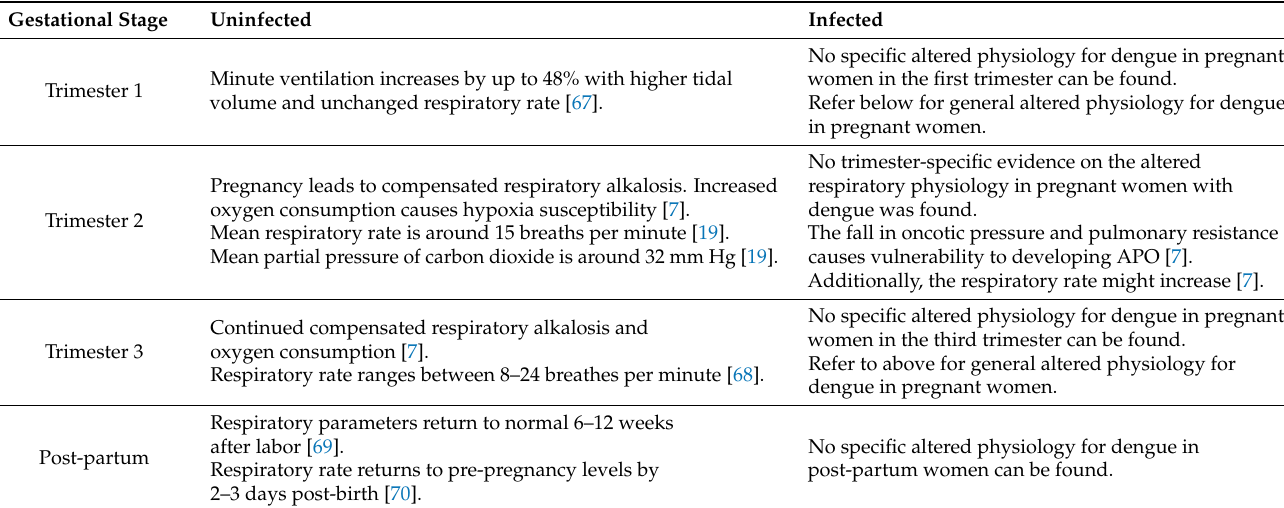
Table 4. Uninfected versus dengue-infected respiratory changes in pregnant